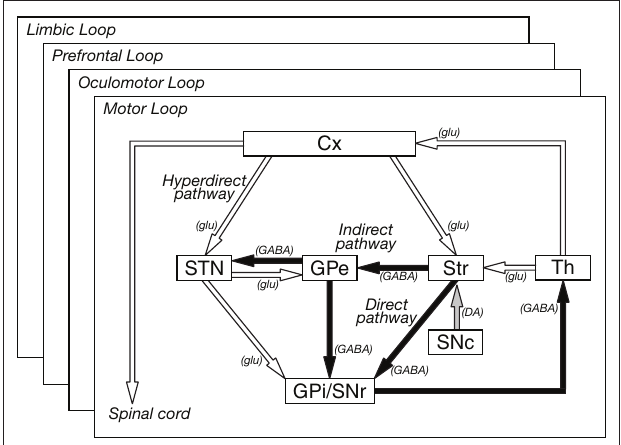
Figure 1 | Basic circuitry of the basal ganglia. Open and filled arrows indicate excitatory and inhibitory projections, respectively. Cx, cerebral cortex: DA, dopamine, GABA, gamma-aminobutyric acid; glu, glutamate; GPe and GPi, external and internal segments of the globus pallidus; SNc, substantia nigra pars compacta; SNr substantia nigra pars reticulata; STN, subthalamic nucleus; Str, striatum; Th, thalamus. Modified from Nambu et al. (2002b).